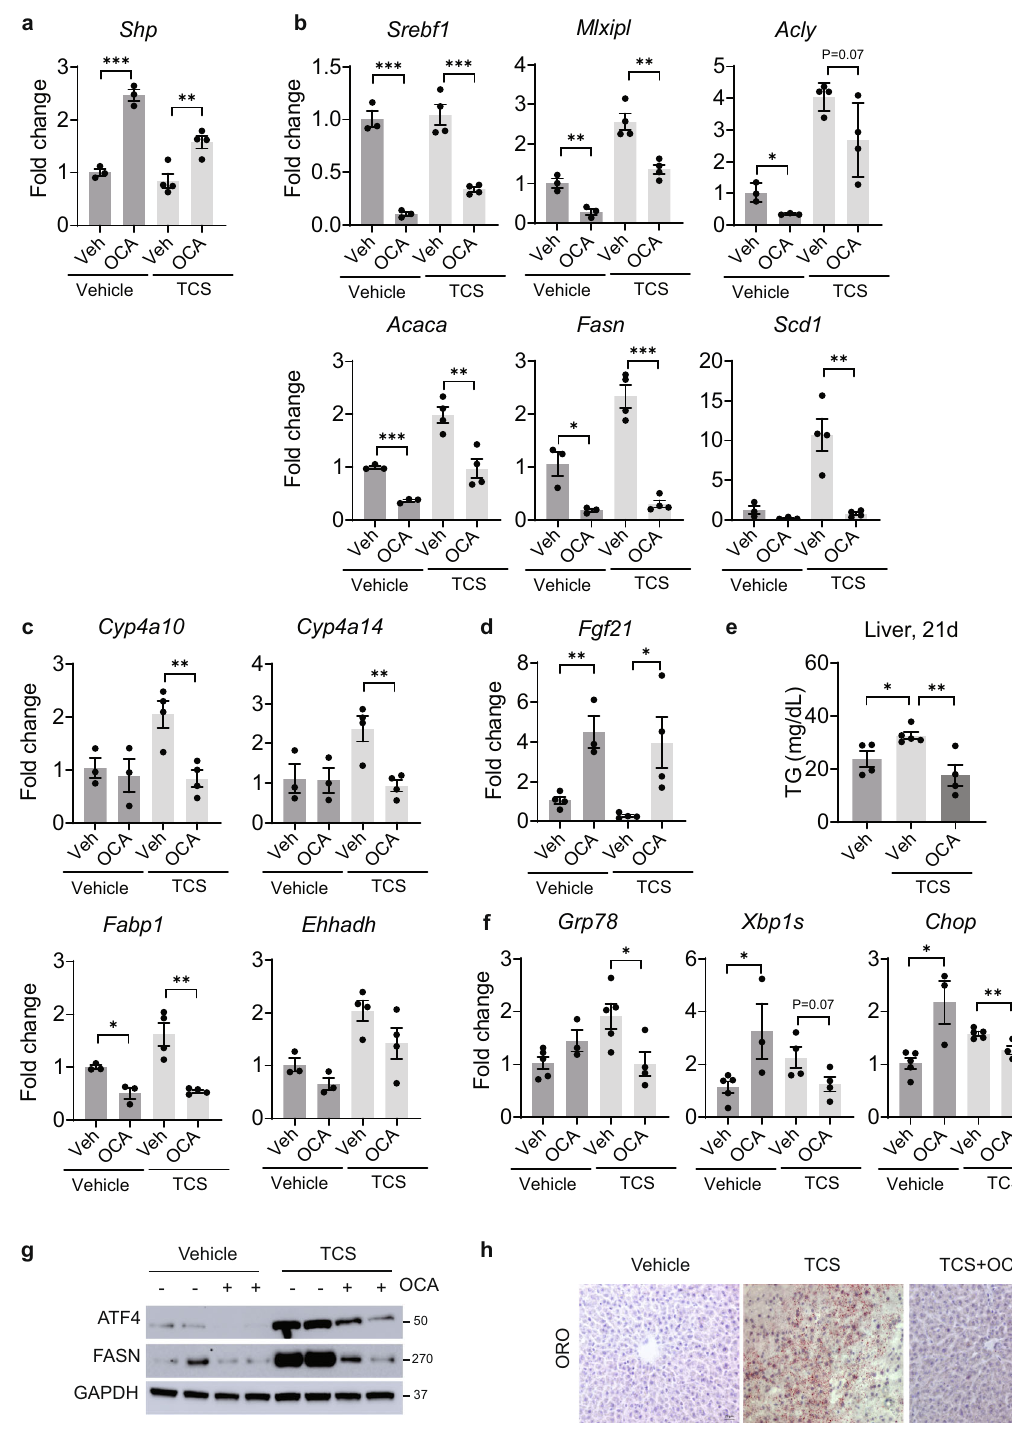
Fig.7|OrallyadministrationofOCAsuppressesDNLgenes,PPAR α activityand ERstressinliverofTCSbreastfedmice. Neonatalmicereceivinganormaldietor TCS through lactation for 21 days. During the course of this exposure, 16-day old miceweretreatedwithOCAfor4daysandtissuescollectedonday21. a Expression of hepatic Shp (vehicle, n =3 per group and TCS, n =4 per group). b Expression of genes associated with lipogenesis (vehicle, n =3 per group and TCS, n =4 per group). c Hepatic expression of PPAR α target genes (vehicle, n =3 per group